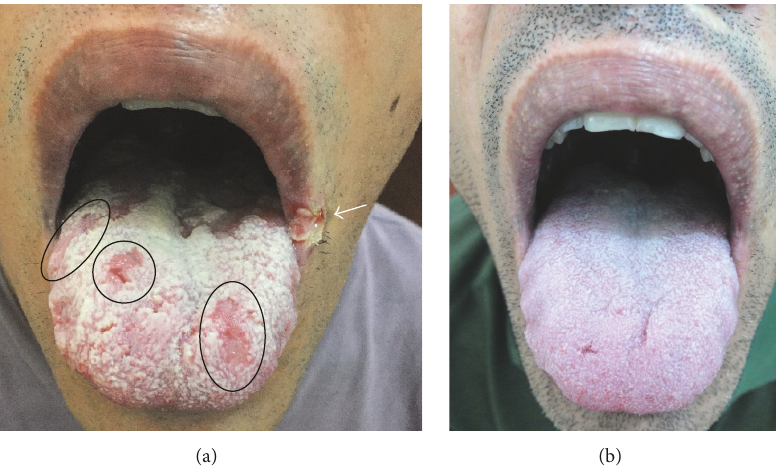
Figure 1: Clinical images of the 45-year-old male patient. (a) Shallow, round to oval depapillary erosions on a background of a whitish, nonwipeable hyperkeratotic thickening of the posterior aspect of the tongue, in a pattern of plaques en prairie fauch´ee . A fibrin-covered commissural papule (split papule) in the left oral commissure is indicated by the arrow. All lesions were very painful. (b) Complete remission after penicillin